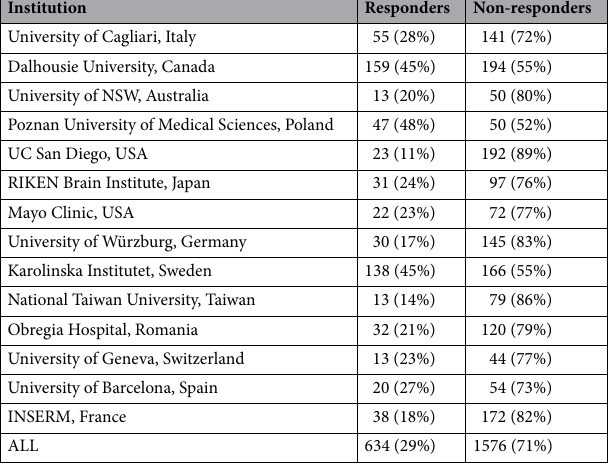
Table 1. Distributions of cases (lithium responders) and controls (non-responders) across